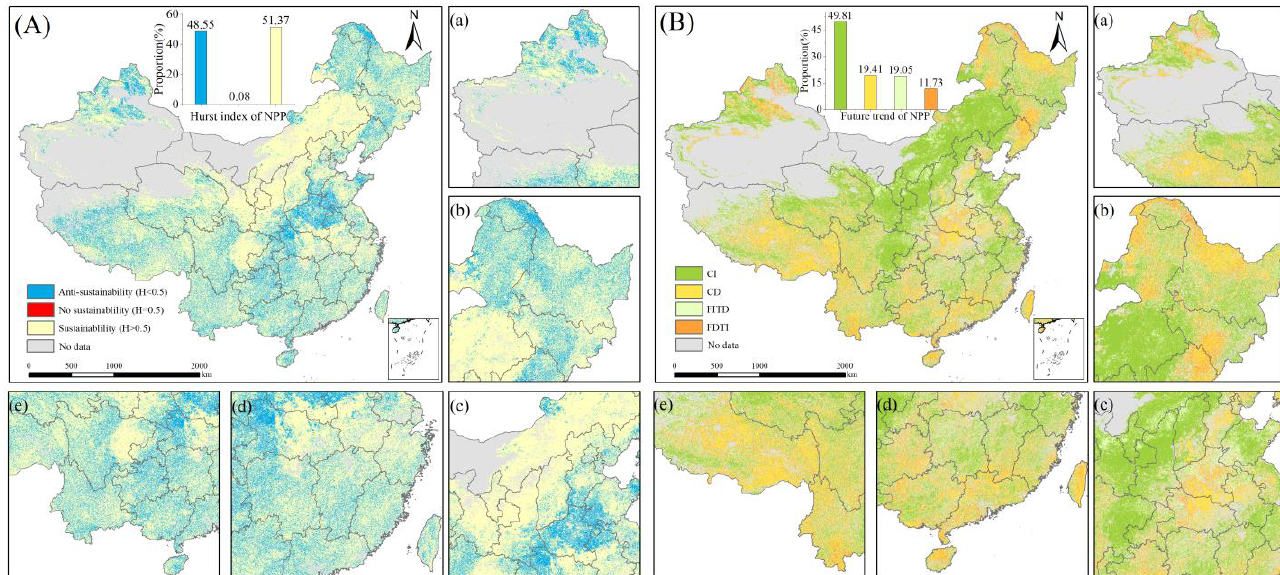
Figure 5. Hurst exponent of NPP ( A ) and future trend of NPP ( B ). CI, continue increase; CD, con- tinue decrease; FITD, from an increasing trend to a decreasing trend; FDTI, from a decreasing trend to an increasing trend. (a)−(e) represent the detailed information for the northwest China, northeast increasing trend. ( a – e ) represent the detailed information for the northwest China, northeast China, China, Central China, southeast China and southwest China, respectively. Central China, southeast China and southwest China,